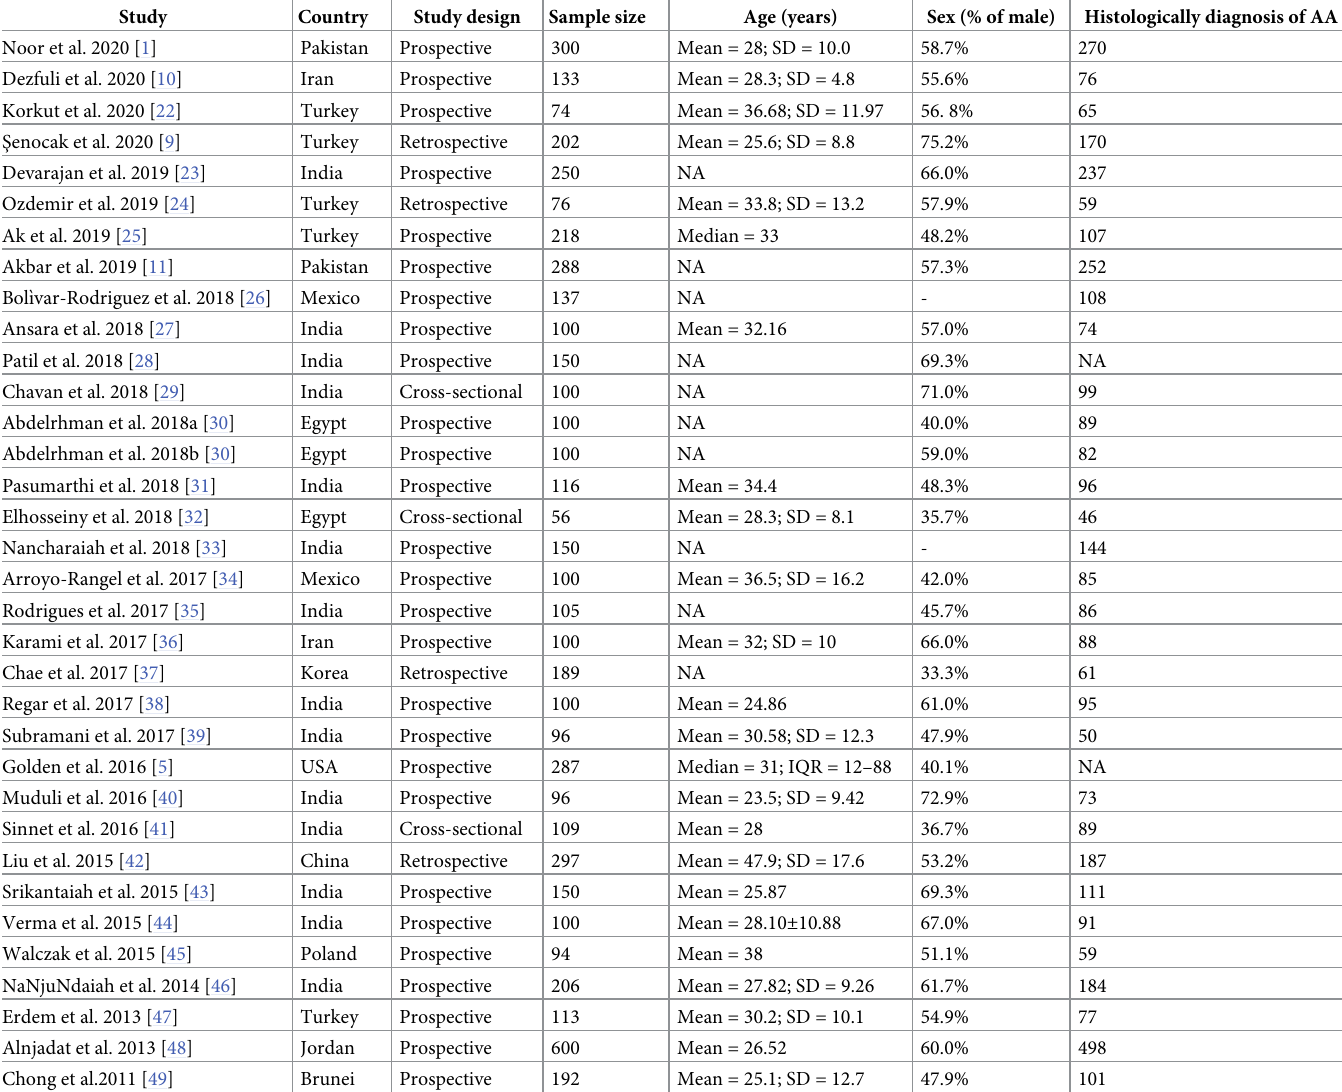
Table 1. Characteristics of studies included in the systematic